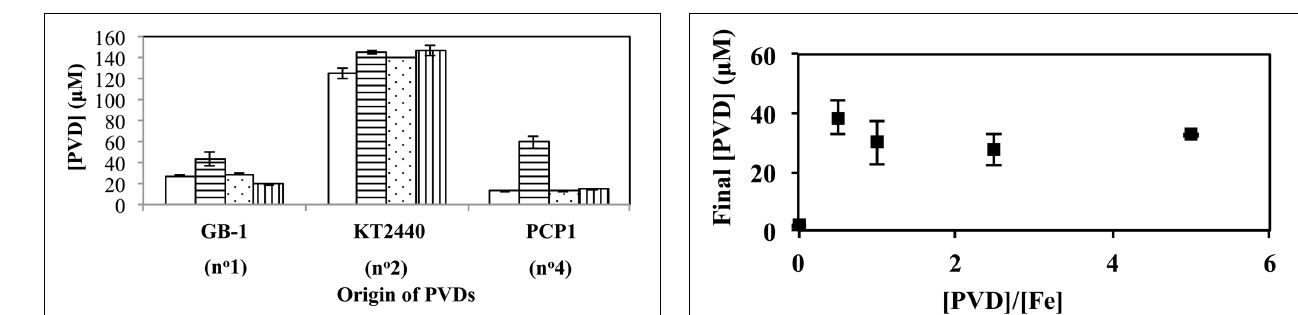
ratio of 0.5 (2 μ M Fe(II) and 1 μ M PVDGB-1),